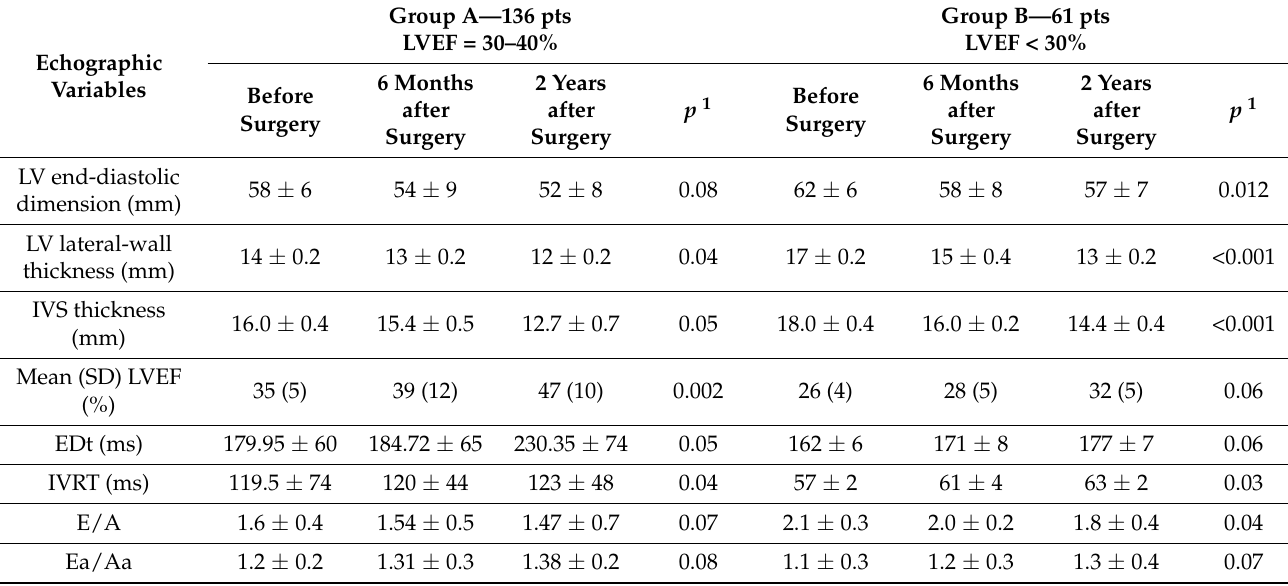
Table 2. Comparison of preoperative and postoperative echocardiographic